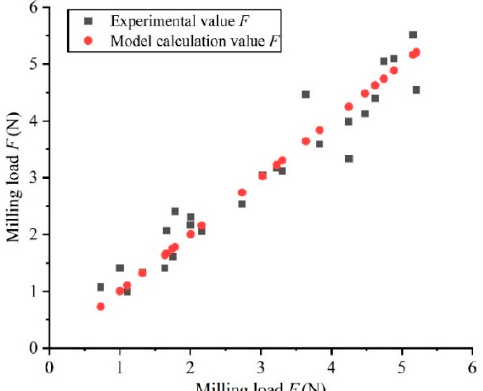
Figure 4. Comparison of model calculation value and experiment measurement value.